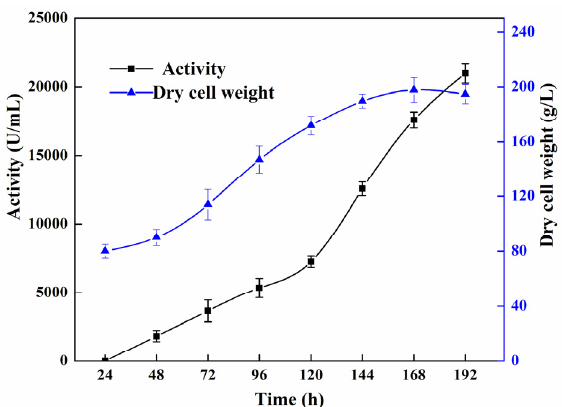
Figure 1. Lipase activity and cell growth in basal salt medium at 30 °C and pH 5.0 during fed-batch fermentation in a 50-L bioreactor. The lipase activity was measured with a pH-stat (Metrohm, Herisau, Switzerland) and using olive oil as substrate at pH 9.0, 40 °C. Dry cell weight was obtained by centrifuging 10 mL samples in a pre-weight centrifuge tube at 8000 g for 10 min and washing twice with deionized water, then allowing the pellet to dry at 105 °C to constant weight.